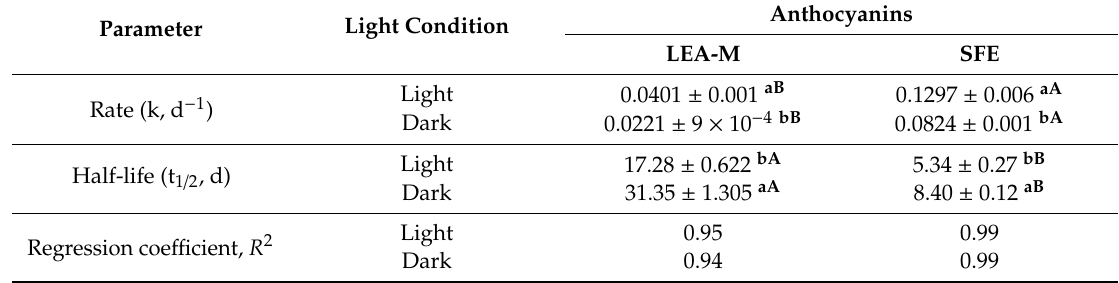
Table 3. E ff ect of light on anthocyanin-rich extracts. (A) Degradation rate, half-life and (B) changes in Table 3. Effect of light on anthocyanin-rich extracts. (A) Degradation rate, half-life and (B) changes in color parameters (L*, a* and b*) of black bean anthocyanins at light and dark conditions after ten days. Table 3. Effect of light on anthocyanin-rich extracts. (A) Degradation rate, half-life and (B) changes in Table 3. Effect of light on anthocyanin-rich extracts. (A) Degradation rate, half-life and (B) changes in Table 3. Effect of light on anthocyanin-rich extracts. (A) Degradation rate, half-life and (B) changes in Table 3. Effect of light on anthocyanin-rich extracts. (A) Degradation rate, half-life and (B) changes in color parameters (L*, a* and b*) of black bean anthocyanins at light and dark conditions after ten days. Table 3. Effect of light on anthocyanin-rich extracts. (A) Degradation rate, half-life and (B) changes in Table 3. Effect of light on anthocyanin-rich extracts. (A) Degradation rate, half-life and (B) changes in color parameters (L*, a* and b*) of black bean anthocyanins at light and dark conditions after ten days. color parameters (L*, a* and b*) of black bean anthocyanins at light and dark conditions after ten days. Table 3. Effect of light on anthocyanin-rich extracts. (A) Degradation rate, half-life and (B) changes in color parameters (L*, a* and b*) of black bean anthocyanins at light and dark conditions after ten days. color parameters (L*, a* and b*) of black bean anthocyanins at light and dark conditions after ten days. color parameters (L*, a* and b*) of black bean anthocyanins at light and dark conditions after ten days. color parameters (L*, a* and b*) of black bean anthocyanins at light and dark conditions after ten days. color parameters (L*, a* and b*) of black bean anthocyanins at light and dark conditions after ten